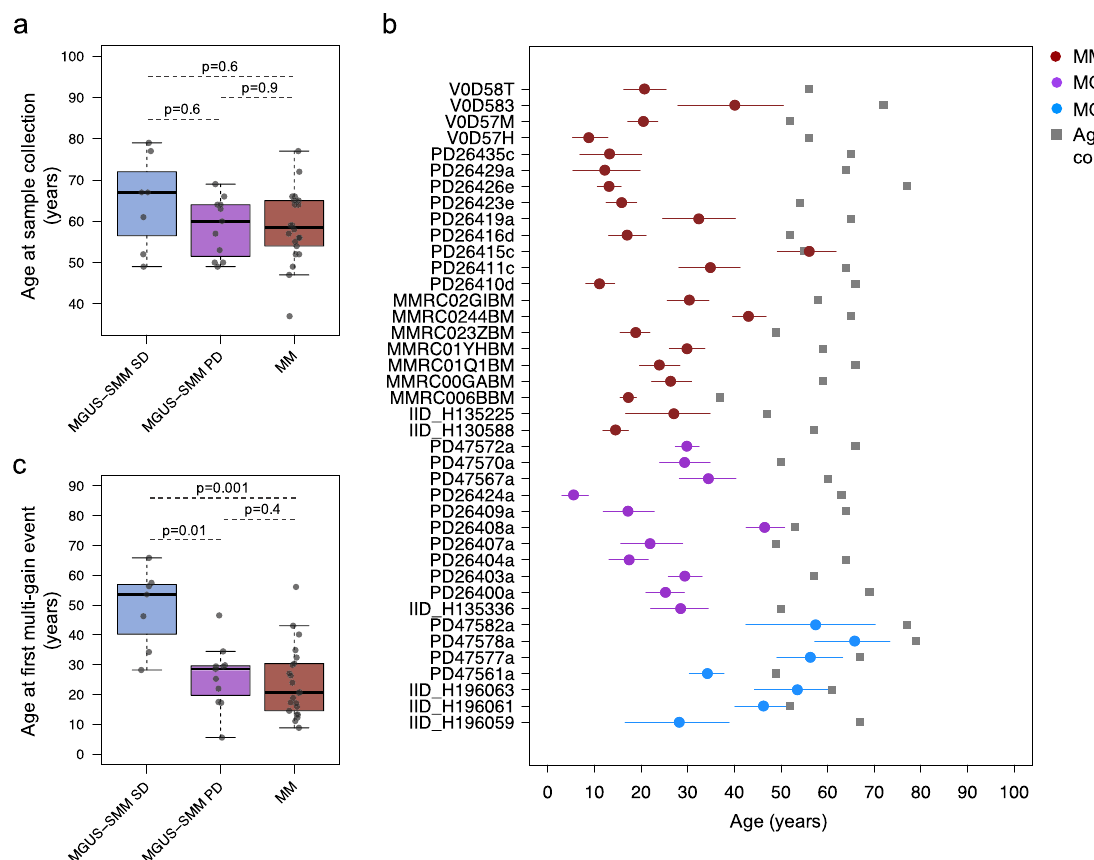
Fig. 6 Timing the acquisition of the fi rst multi-gain event in multiple myeloma (MM) and myeloma precursor conditions. a Comparison of the patients ’ age at the time of sample collection between stable ( N = 15), progressive ( N = 17) myeloma precursors and MM ( N = 80). p values were calculated using the Wilcoxon rank-sum test. b Estimated patient age at the fi rst multi-gain events with 95% con fi dence of intervals. Blue, purple and brown dots and lines represent stable ( N = 7), progressive ( N = 11) myeloma precursors, and MM ( N = 22) respectively. Gray boxes re fl ect the sample collection time. c Comparison of estimated patient age at the fi rst multi-gain events between stable, progressive myeloma precursors and MM. p values were calculated using the Wilcoxon rank-sum test. For ( a , c ) boxplots show the median and interquartile range. MGUS: monoclonal gammopathy of undetermined signi fi cance, SMM: smoldering multiple myeloma, SD: stable, PD: